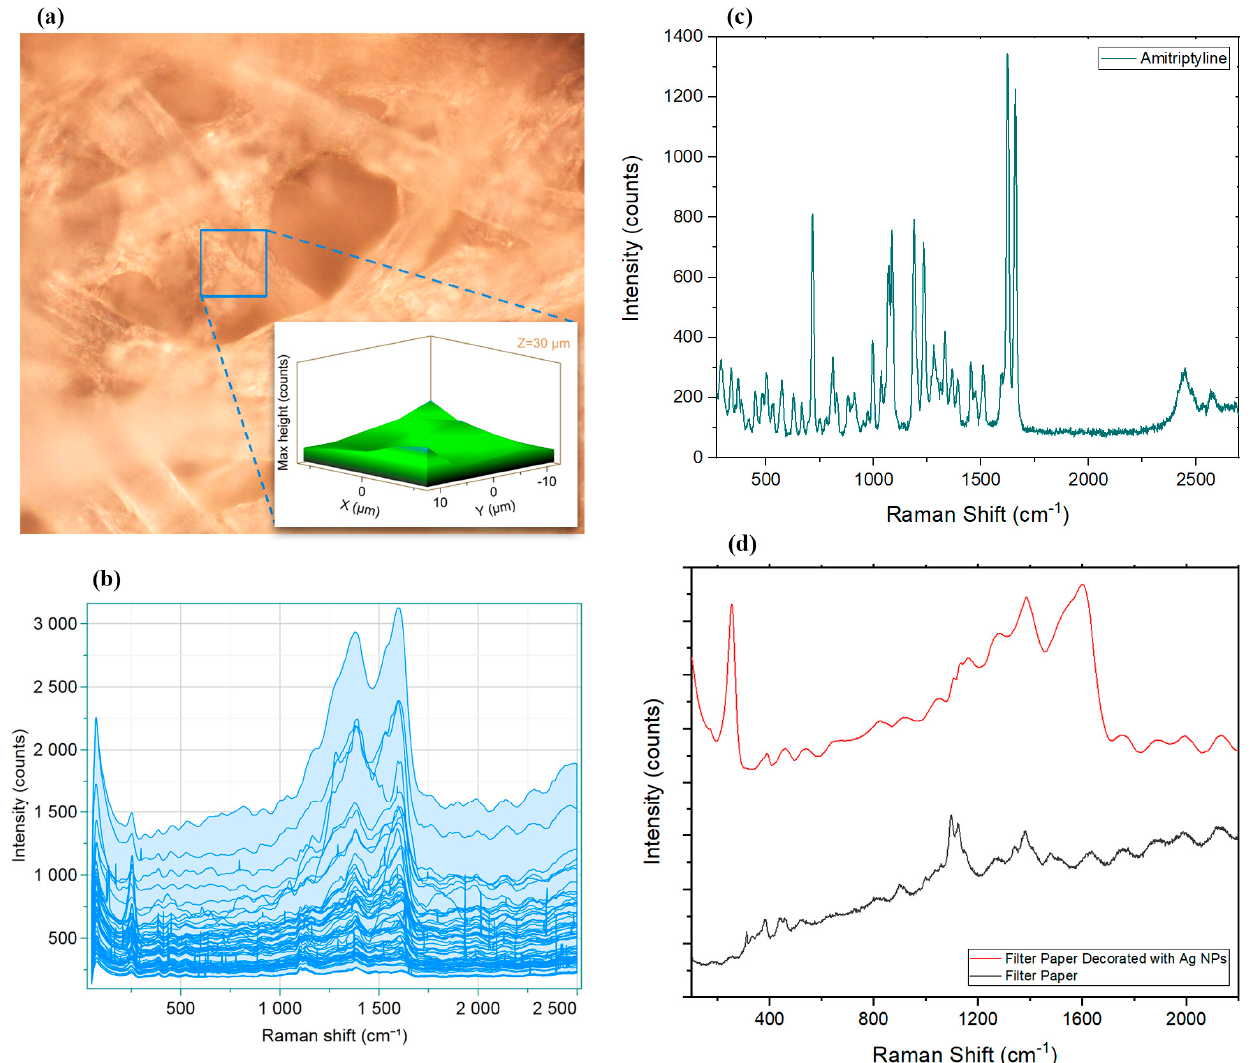
Figure 3. ( a ) SERS 3D mapping of a rectangular area of 20 μ m (X-axis) × 20 μ m (Y-axis) × 10 μ m (Z-axis) of AgNP-decorated filter paper. ( b ) Data obtained from studying 125 data points in the same area, showing the entire hyperspectral dataset of spectra collected. Raman spectrum of pristine AMT crystals demonstrated in ( c ). ( d ) Raman spectra of filter paper before and after modification with AgNPs.